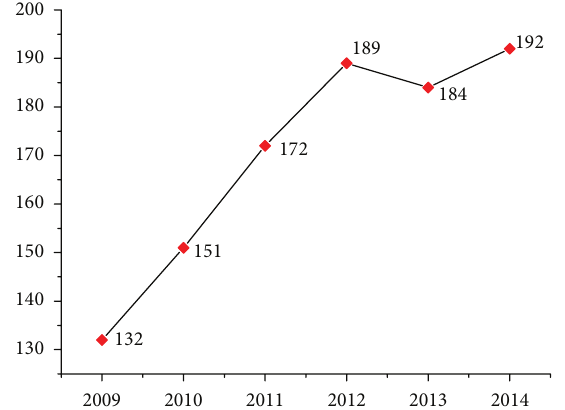
Table 4: Relative prediction errors of four